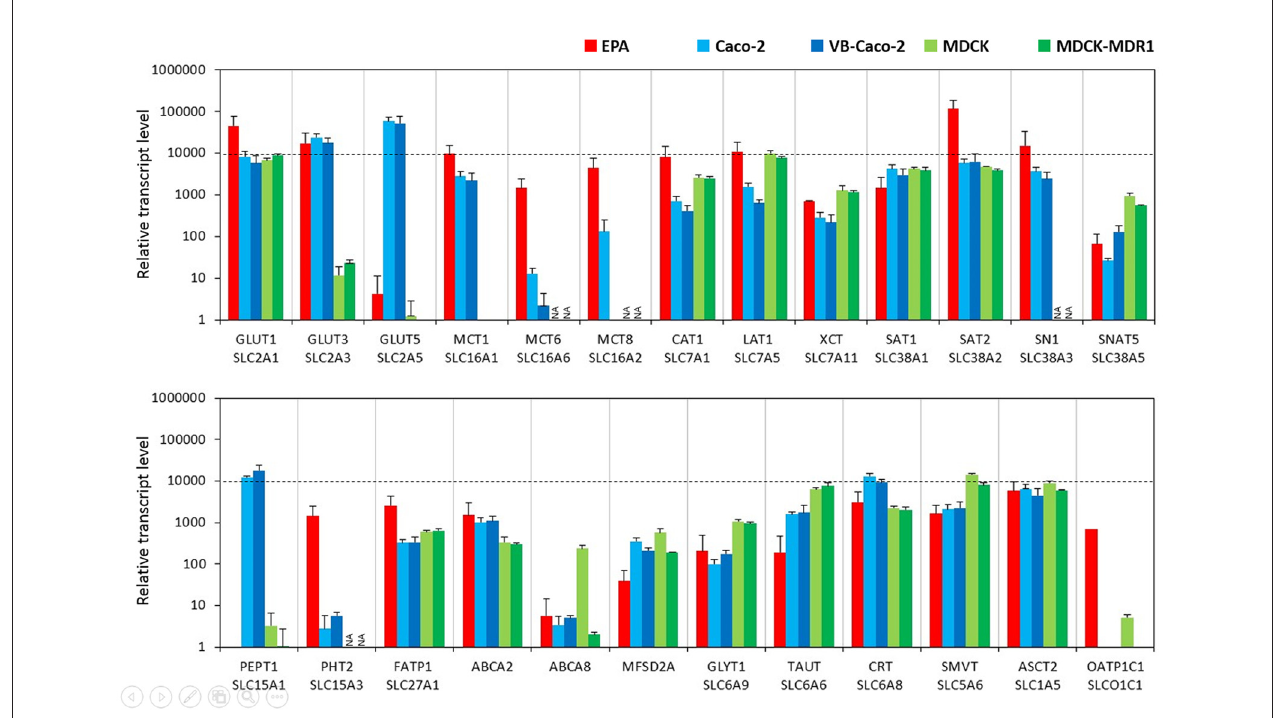
FIGURE 2 | Relative transcript levels of selected genes encoding solute carriers (SLC) and other nutrient transporters measured by inventoried TaqMan Gene Expression Assays in a primary rat brain endothelial cell-based BBB model (EPA) and in epithelial cell line models (Caco-2, VB-Caco-2, MDCK and MDCK-MDR1). NA: assay not